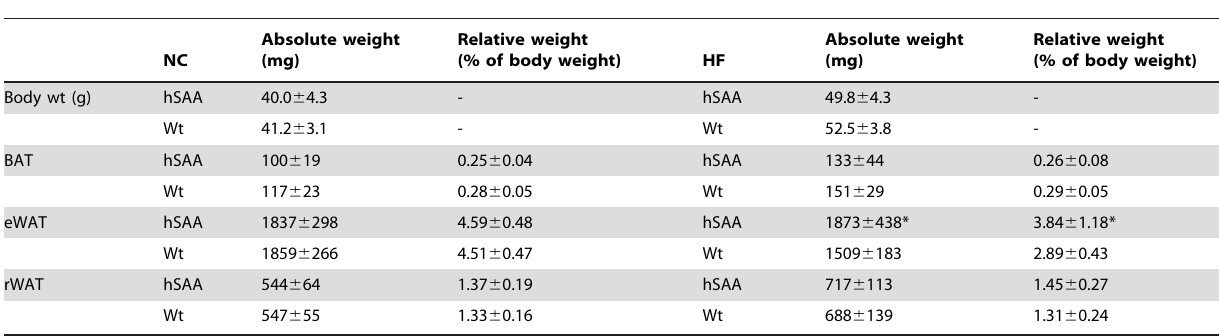
Values are presented as mean 6 SD. Body wt, body weight; NC, normal chow; HF, high fat; BAT, brown adipose tissue depot; eWAT, epididymal white adipose tissue depots; rWAT, retroperitoneal white adipose tissue depots; hSAA, hSAA male animals; Wt, wild type male animals. n(NC, hSAA)=7, n(NC, Wt)=8, n(HF, hSAA)=10 and n(HF, Wt)=10. *p , 0.05 between hSAA and Wt